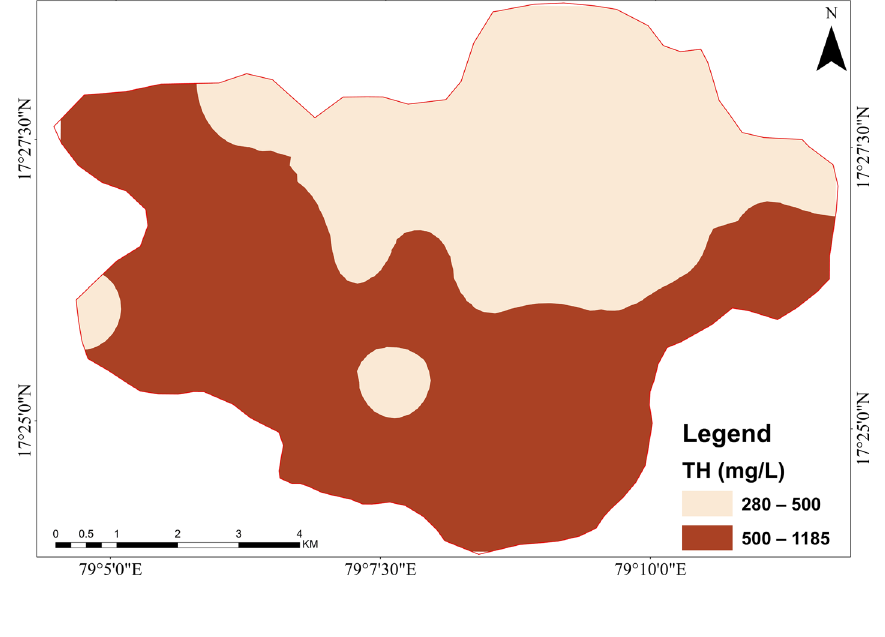
Fig. 6 Spatial distribution map of Na + in Mothkur region, Tel- angana State, South